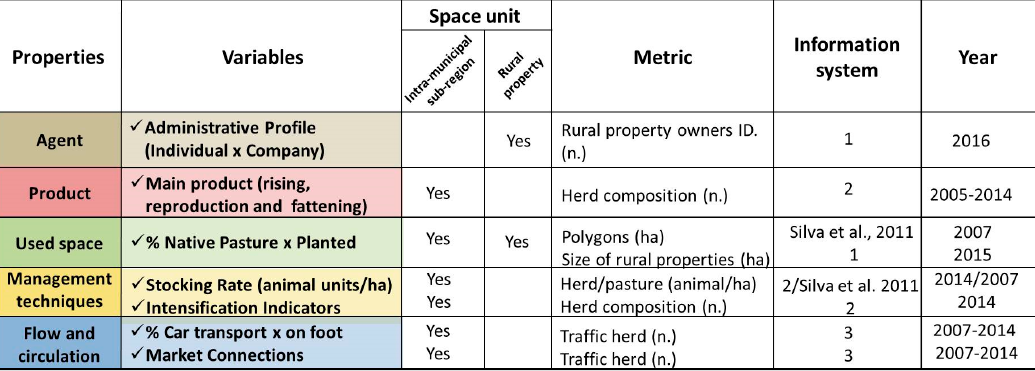
Figure 2. Variables that represent the properties strutuctures of the cattle breeding of the South Pantanal. 1 Land Collection (SIGEF)/Brazilian National Institute of Colonization and Agrarian Reform (INCRA), 2 Mouth Disease Vaccination Campaign by Animal and Plant Health Defense Agency of Mato Grosso do Sul State (IAGRO) 3 Animal Movement Permits by Animal and Plant Health Defense Agency of Mato Grosso do Sul State (IAGRO)—Source: Adapted from Araujo (2018). Identification of the agents was obtained from the SIGEF/INCRA, from 2016. This